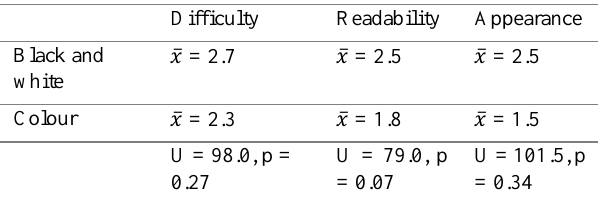
Subjective analysis results for first code snippet